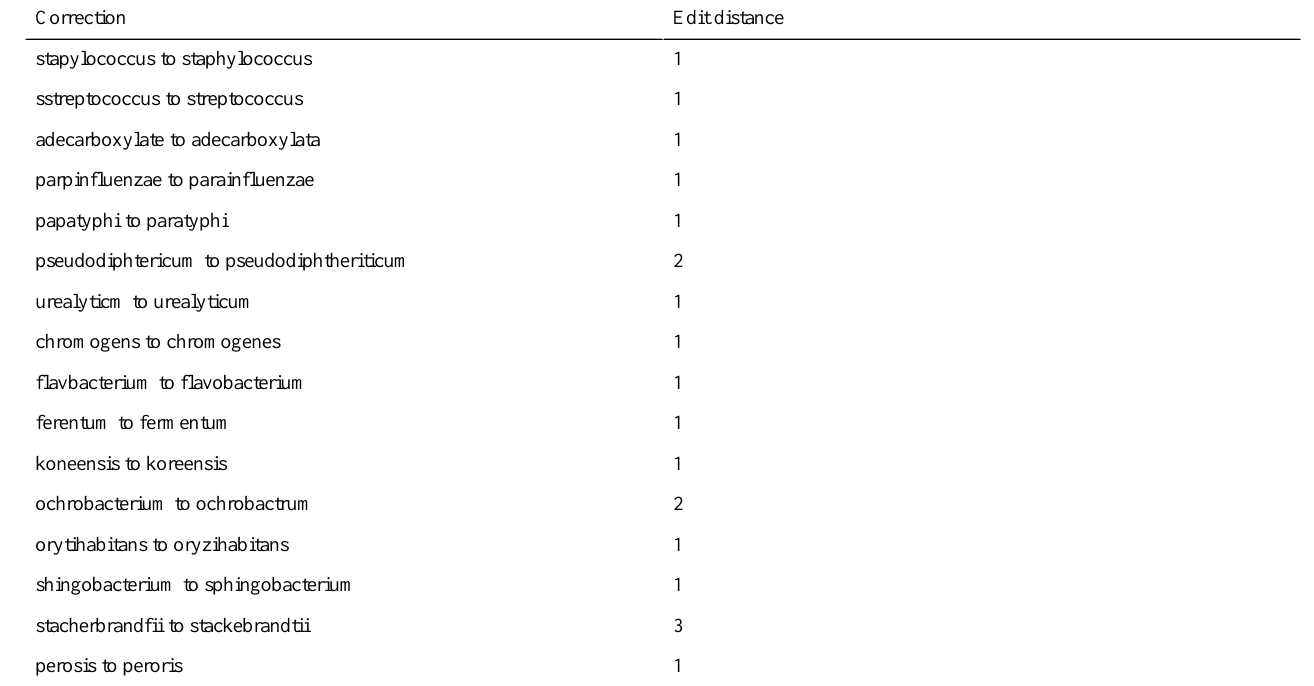
Table 2. Correction table using edit